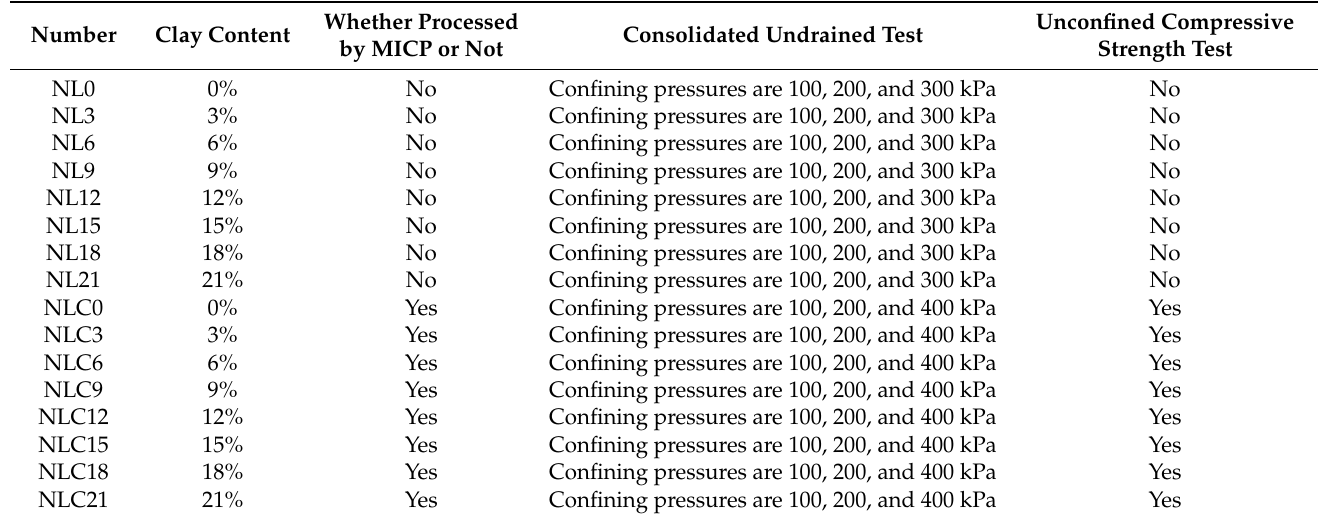
Table 3. Different clay content test schemes.